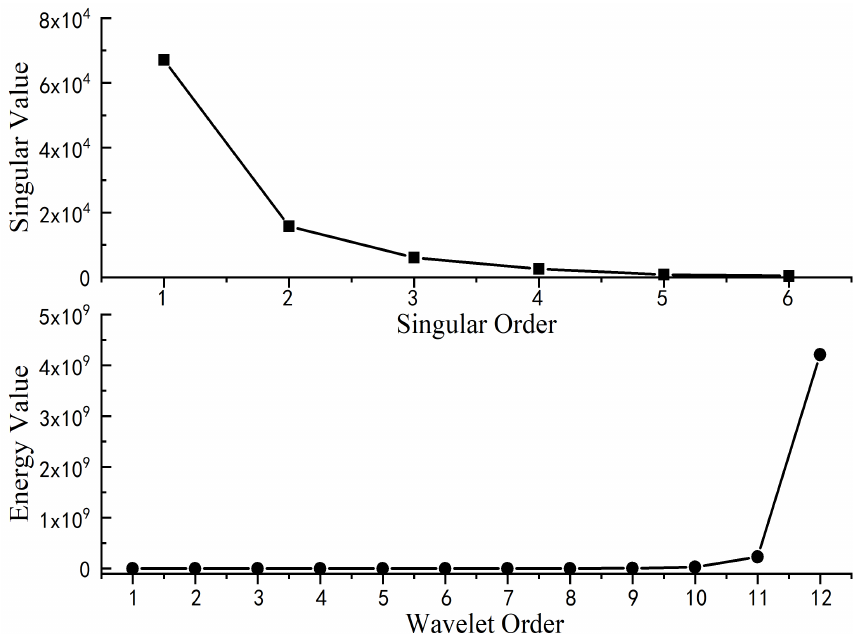
Figure 10. Singular values and wavelet energy values of power frequency AC voltage of each order.